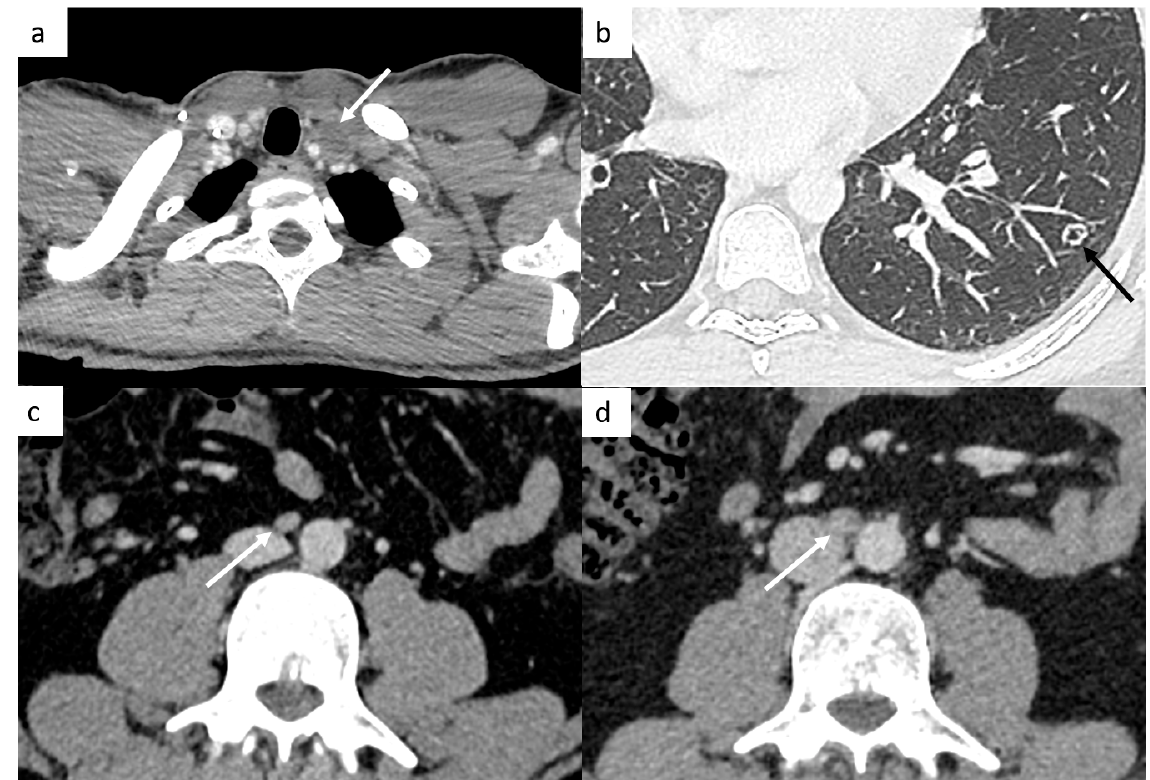
Figure 4. Small disease. Thoracic CT reveals a small left supraclavicular lymph node ( a , arrow). Lung metastases can appear as different features such as small nodules which may be excavated ( b ). Abdominal CT demonstrates a small interaorticocaval lymph node ( c ) and the repetition of the CT 6 months later shows an increasing size of this lymph node, a finding indicative of involvement ( d ).